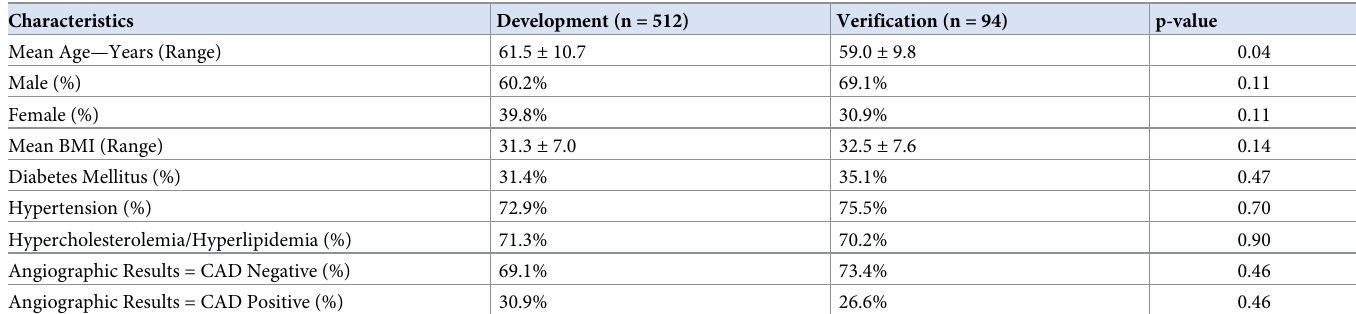
Table 1. Demographics of